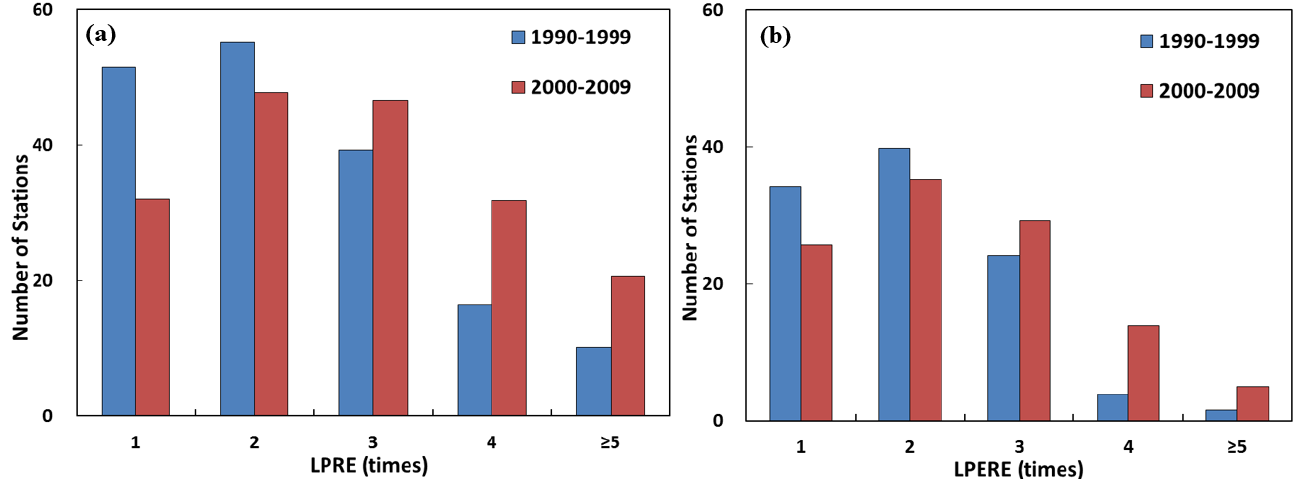
Figure 5. ( a ) The numbers of stations where LPREs occurred for different times during the two periods 1990–1999 (blue bars) and 2000–2009 (red bars). ( b ) As in ( a ), but for LPEREs.